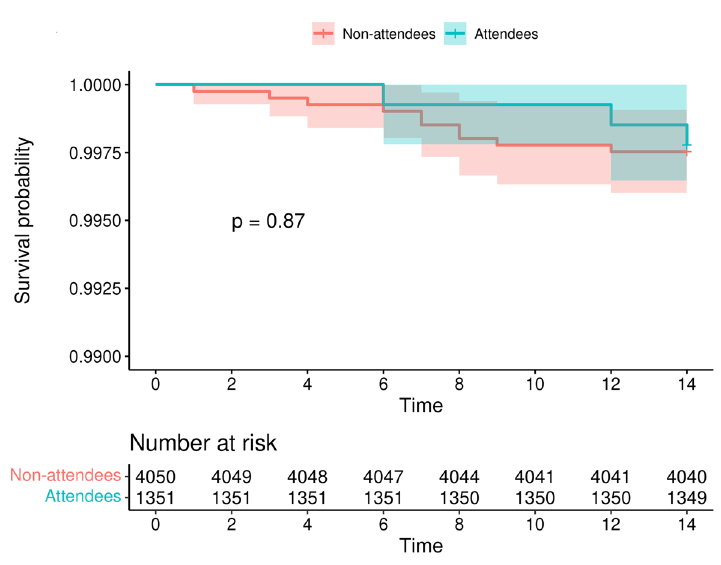
Figure 2. Kaplan–Meier survival curves by group during 14 days of follow-up (n =